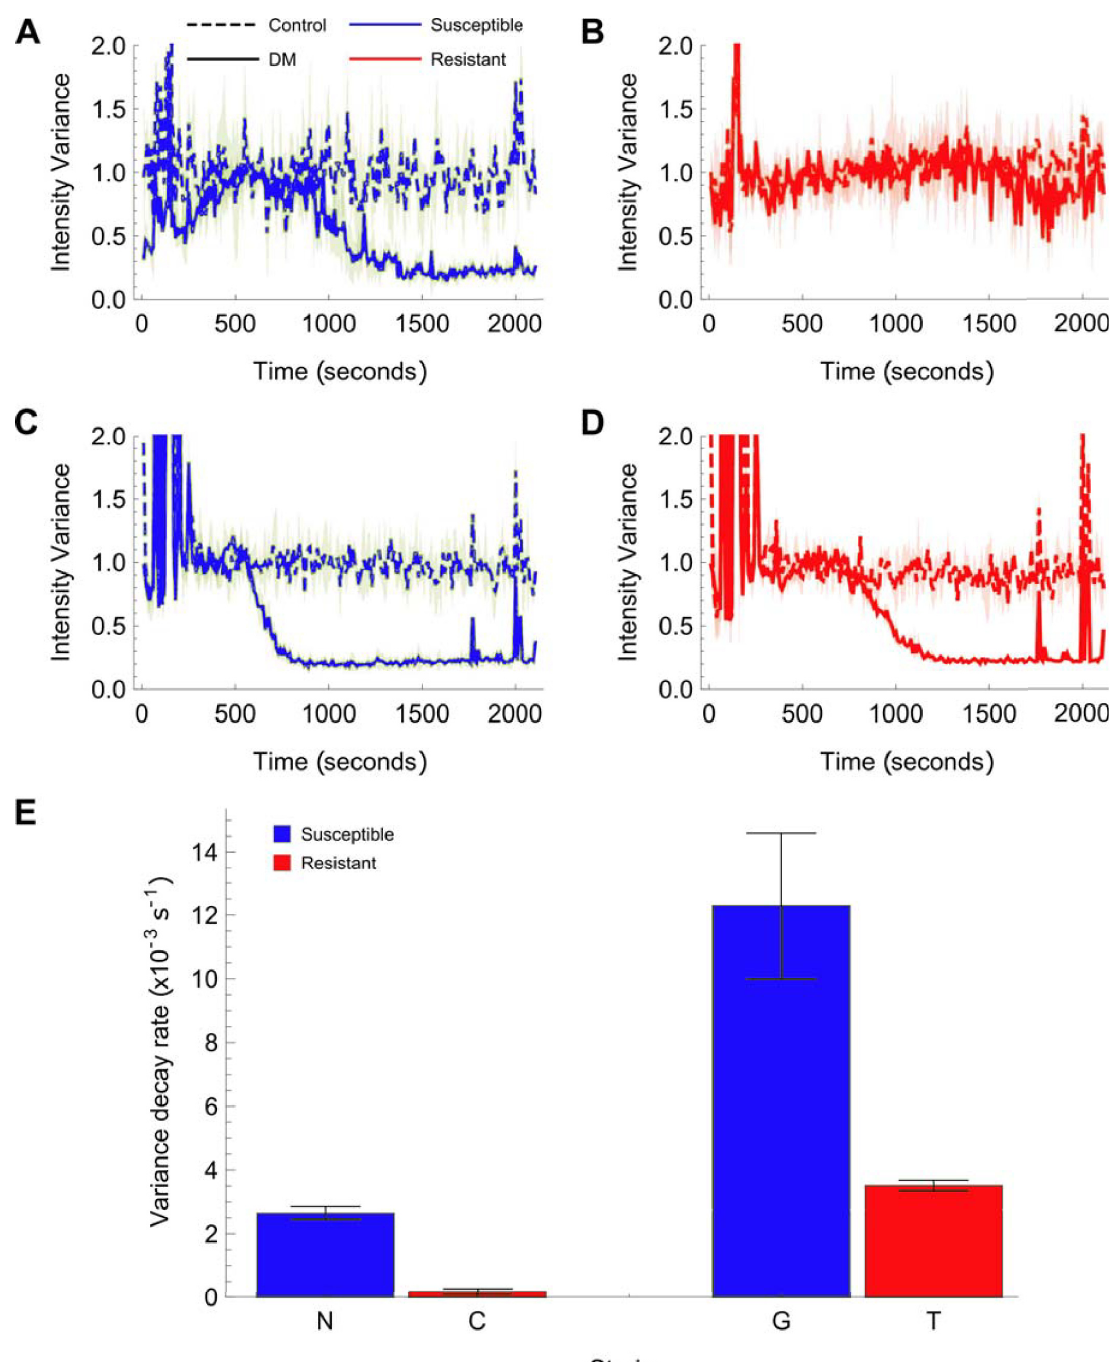
Fig 5. The output of a smartphone application that measures mosquito larvae motility following deltamethrin treatment, quantified by the average pixel variance over 2 s. (A) and (B) show the pixel variance over time (motility) of Aedes aegypti New Orleans and Cayman larvae with 10 − 5 M deltamethrin in water and DMSO/water only controls. The spike at t 200s is the addition of the deltamethrin or control (water). The solid lines show the mean and the shaded area, the standard deviation (n = 3). The susceptible strain (A) motility decreases over time with DM added, whilst the resistant strain (B) does not. (C) and (D) show the pixel variance over time of Anopheles gambiae G3 and An . coluzzii Tiassale larvae with 10 − 5 M deltamethrin in water and DMSO/water controls. In this case, the resistant strain variance also decreases, but at a slower rate. (E) Fitting the variance over time of all the DM samples to exponential decay functions allows the extraction of the decay rate in each case (see methods). These are plotted on the bar chart with error bars showing the standard deviation of the fitted